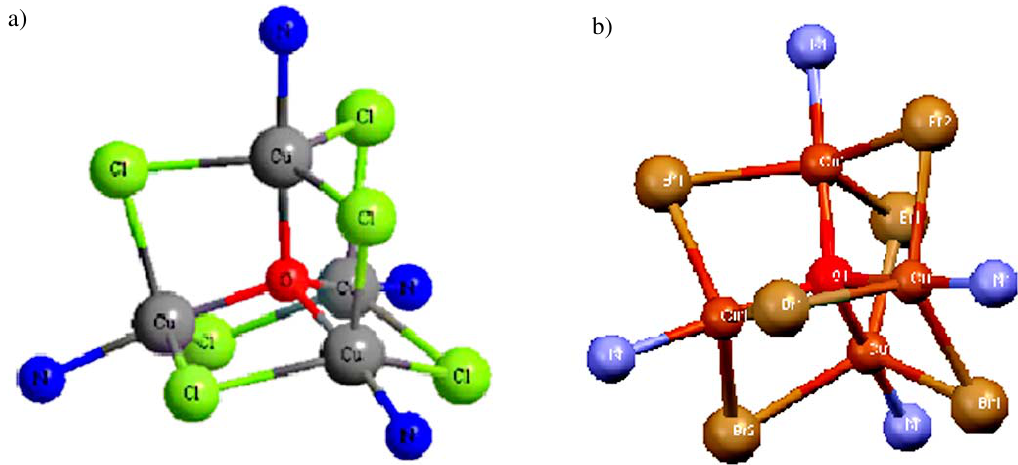
Figure. 3. Cluster core ( a ) cluster 1 and ( b ) cluster 2